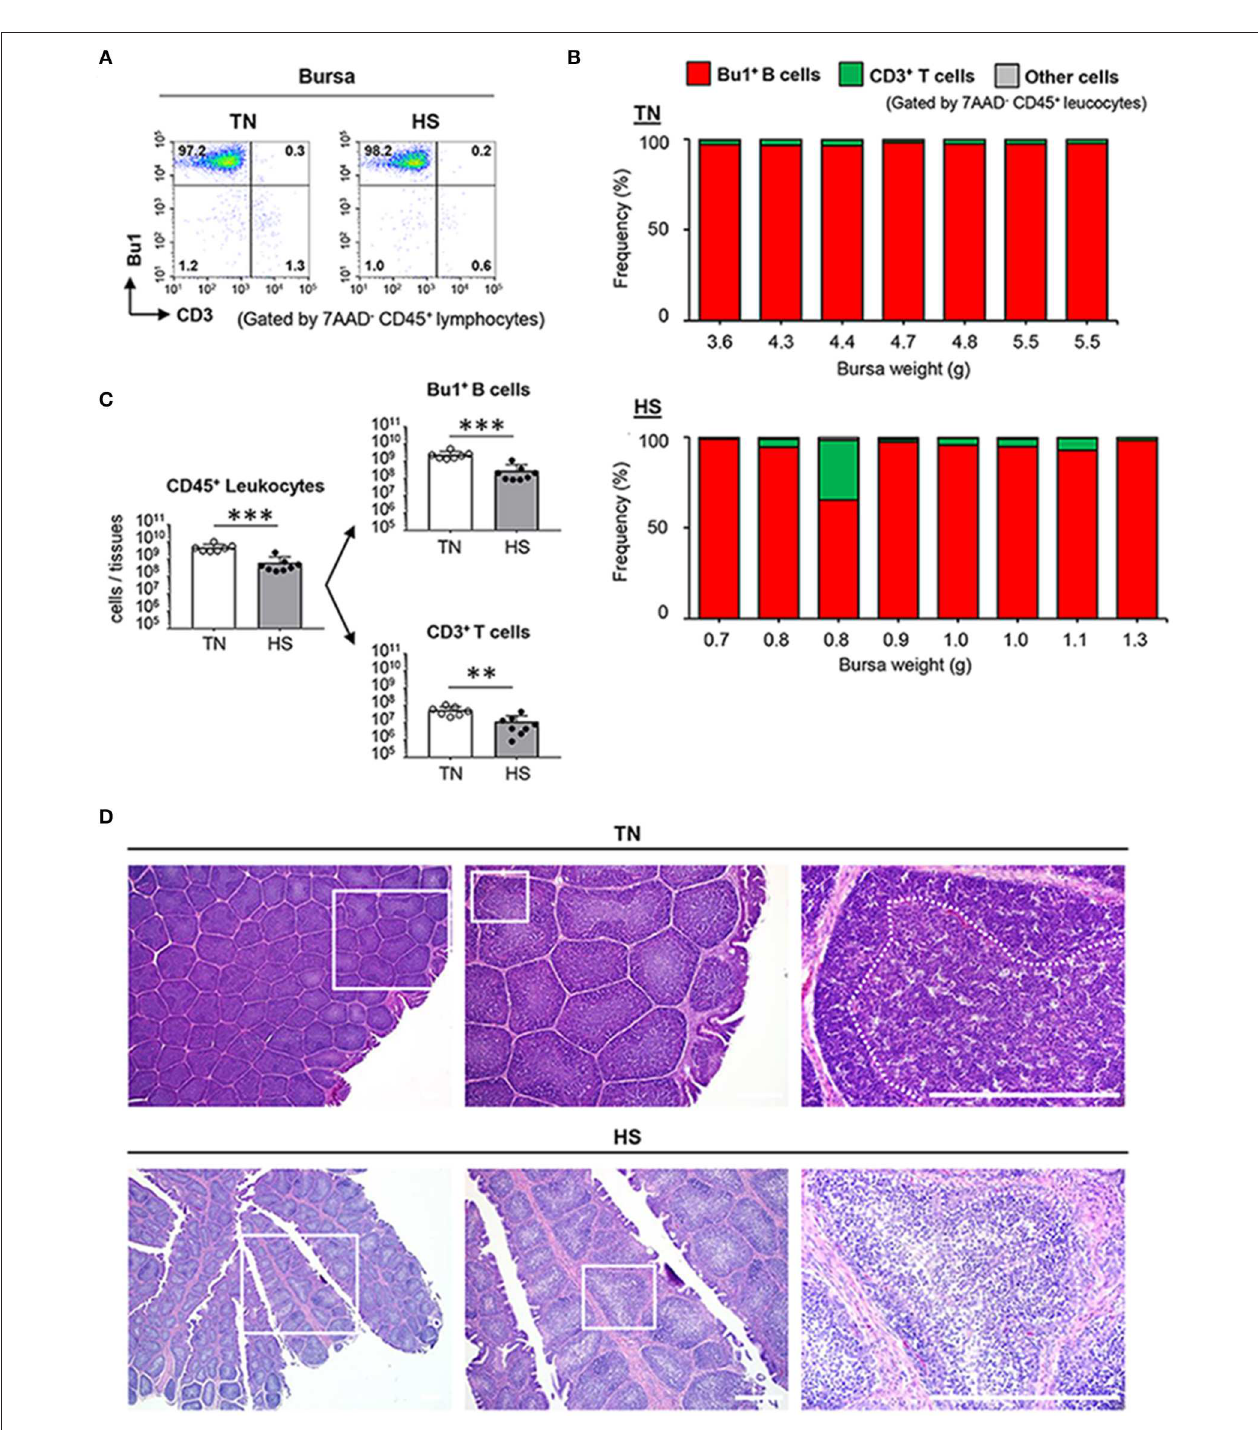
FIGURE 4 | Effect of HS on the functional maturation of B cells in the bursa of Fabricius. Broiler chickens were maintained in either TN or HS condition for 14 days (A,B) . Representative flow cytometry profiles of 7AAD − CD45 + leucocytes in bursa of Fabricius at 36 days of age (C) . Cell components of bursal CD45 + leucocytes, including CD3 + T cells, Bu1 + B cells, other cells, and absolute number of bursal CD45 + leucocytes, Bu1 + B cells, and CD3 + T cells were analyzed by flow cytometry (D) . Representative hematoxylin and eosin-stained histological sections of bursa of Fabricius at 36 days of age. Scale bar: 200 µ m. Dotted line: Border between cortex and medulla. The data are presented as mean ± SE ( n = 7–8/group). ** p < 0.01, *** p < 0.001 compared with the TN group (unpaired two-tailed Student’s t- test). IFE, interfollicular epithelium; FAE, follicle-associated